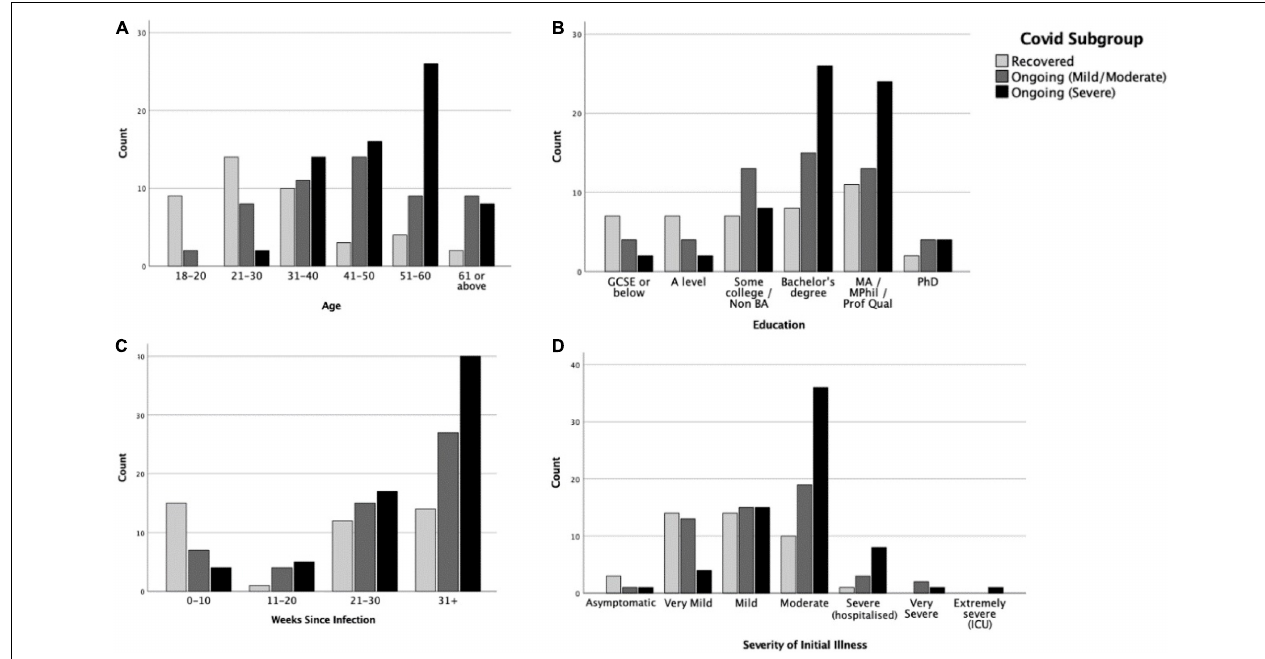
FIGURE 3 | Distributions of (A) age, (B) education level, (C) weeks since infection, and (D) severity of initial illness in Recovered, Ongoing (Mild/Moderate) and Ongoing (Severe) subgroups.